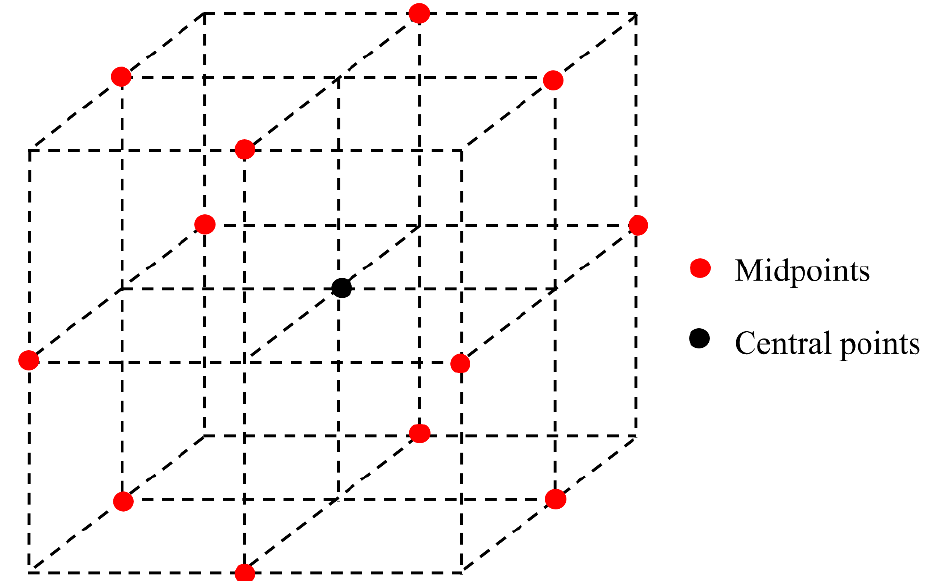
Figure 12. Site distribution diagram of BBD test.